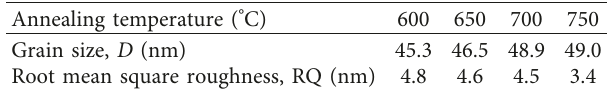
Figure 1: 2D-3D AFM images of BNKT films at different crystallization temperatures: (a) S600, (b) S650, (c) S700, and (d) S750; (e) FE-SEM micrographs of sample S700; (f) cross-sectional SEM image of sample S700. Table 1: The grain size and root mean square roughness as a function of the annealing